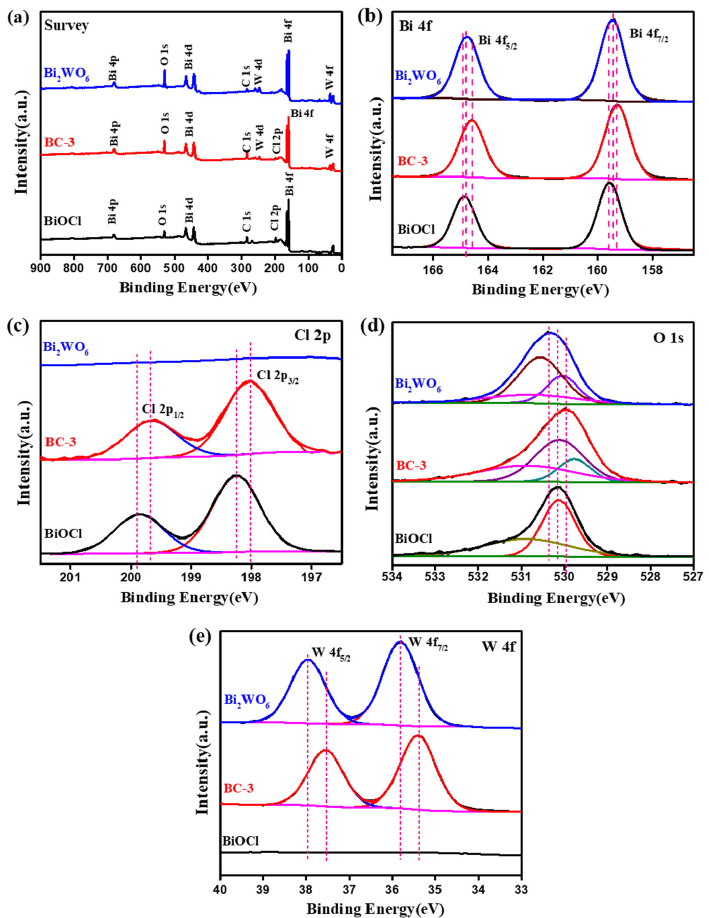
Figure 5. XPS spectra of pure BiOCl, Bi 2 WO 6 , and BC-3: survey spectrum ( a ), Bi4f ( b ), Cl 2p ( c ), O 1s ( d ), and W 4f ( e ).